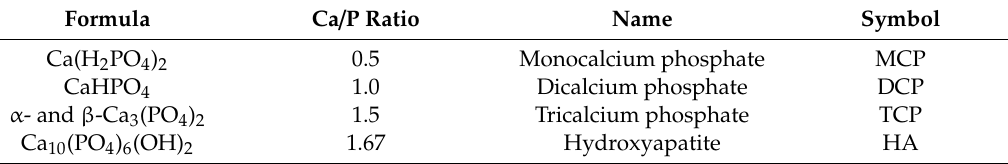
Table 1. Naturally occurring most common calcium phosphate